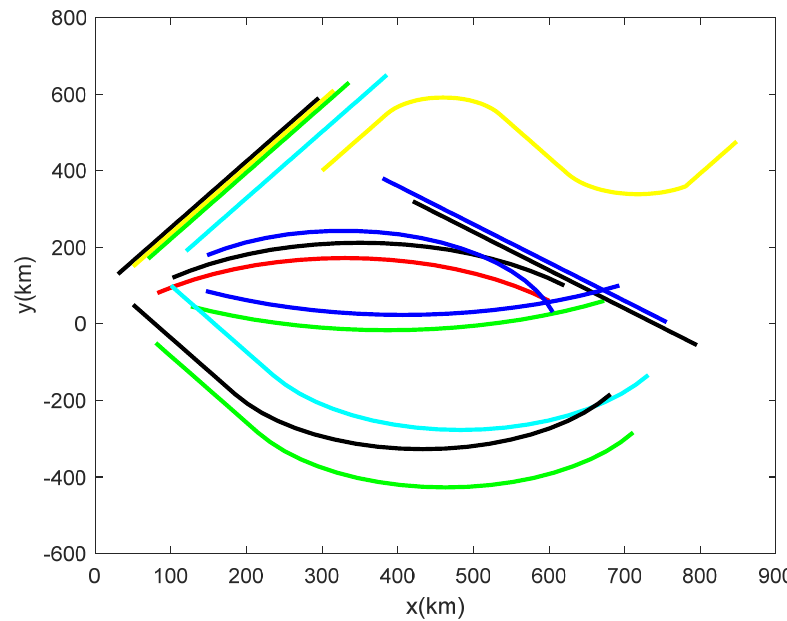
Figure 4. Two − dimensional coordinate system trajectory diagram.